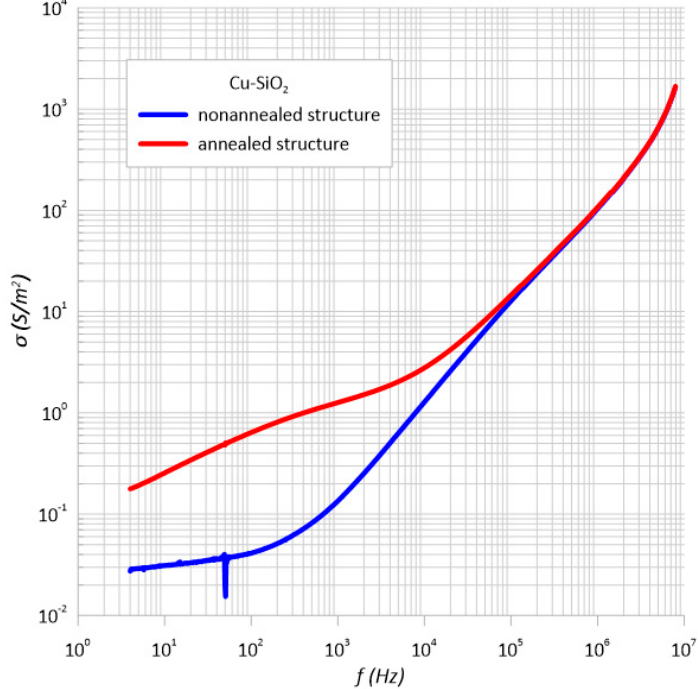
Figure 3. Frequency dependence of the conductivity of the Cu-SiO 2 nanocomposite measured at room temperature before and after annealing.